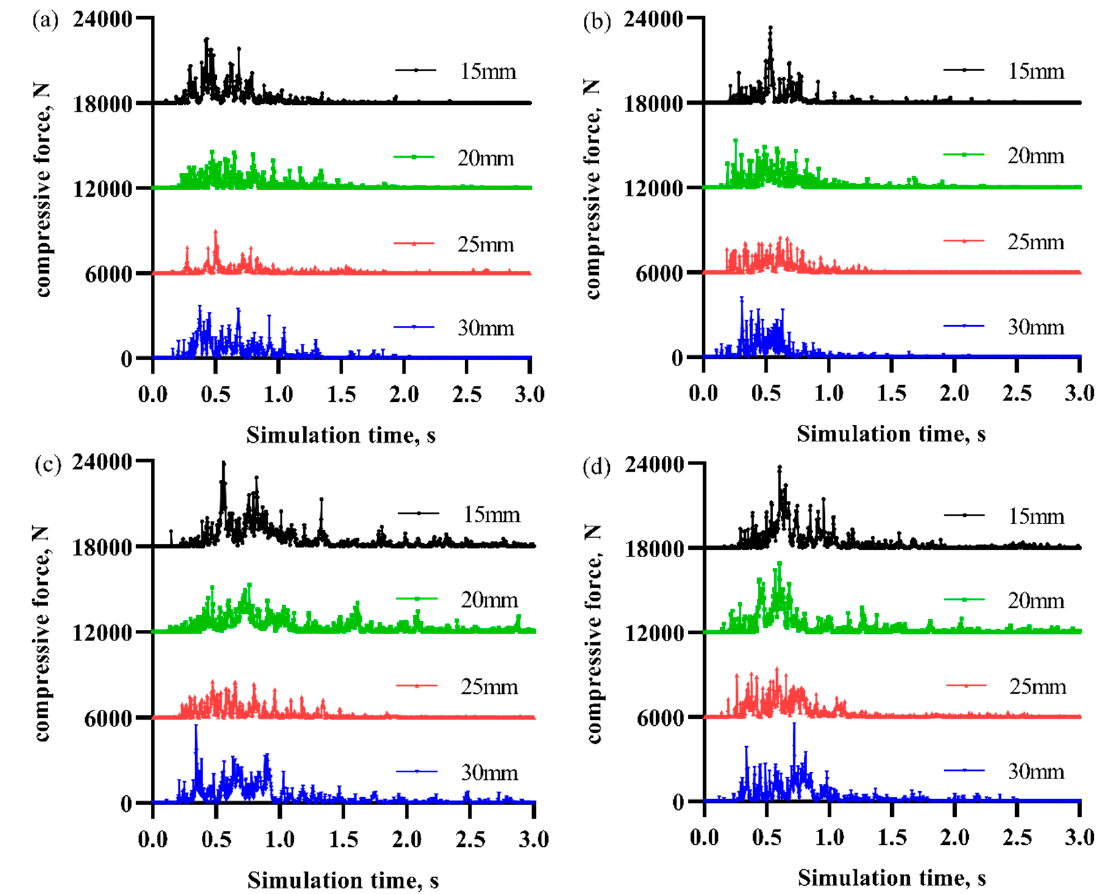
Figure 8. Effects of the width of threshing component on the kernel total compressive force at the rate of drum rotation of ( a ) 122.70 rpm, ( b ) 187.15 rpm, ( c ) 252.10 rpm and ( d ) 317.15 rpm.